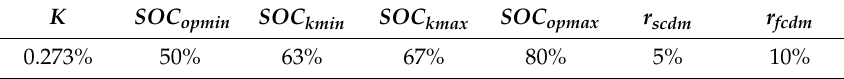
Table 1. Frequency regulation (FR)-ESS operating